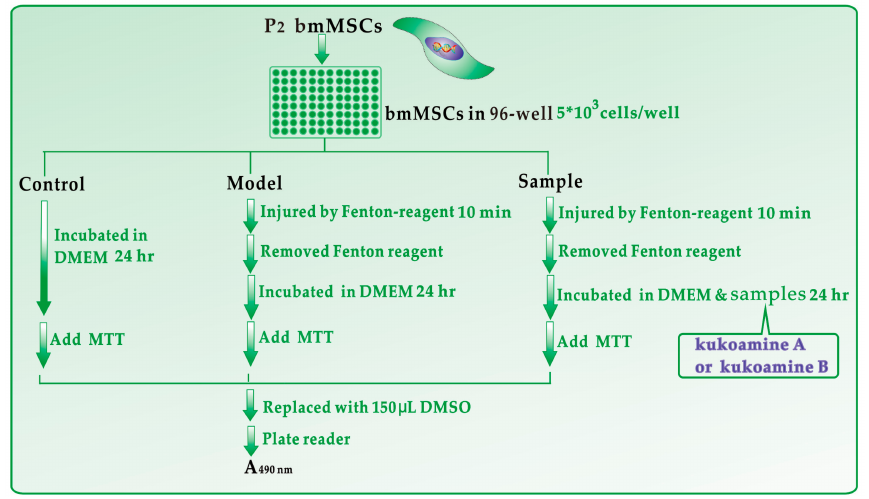
Figure 9. Experimental procedures for the MTT assay. Each test was repeated in five independent